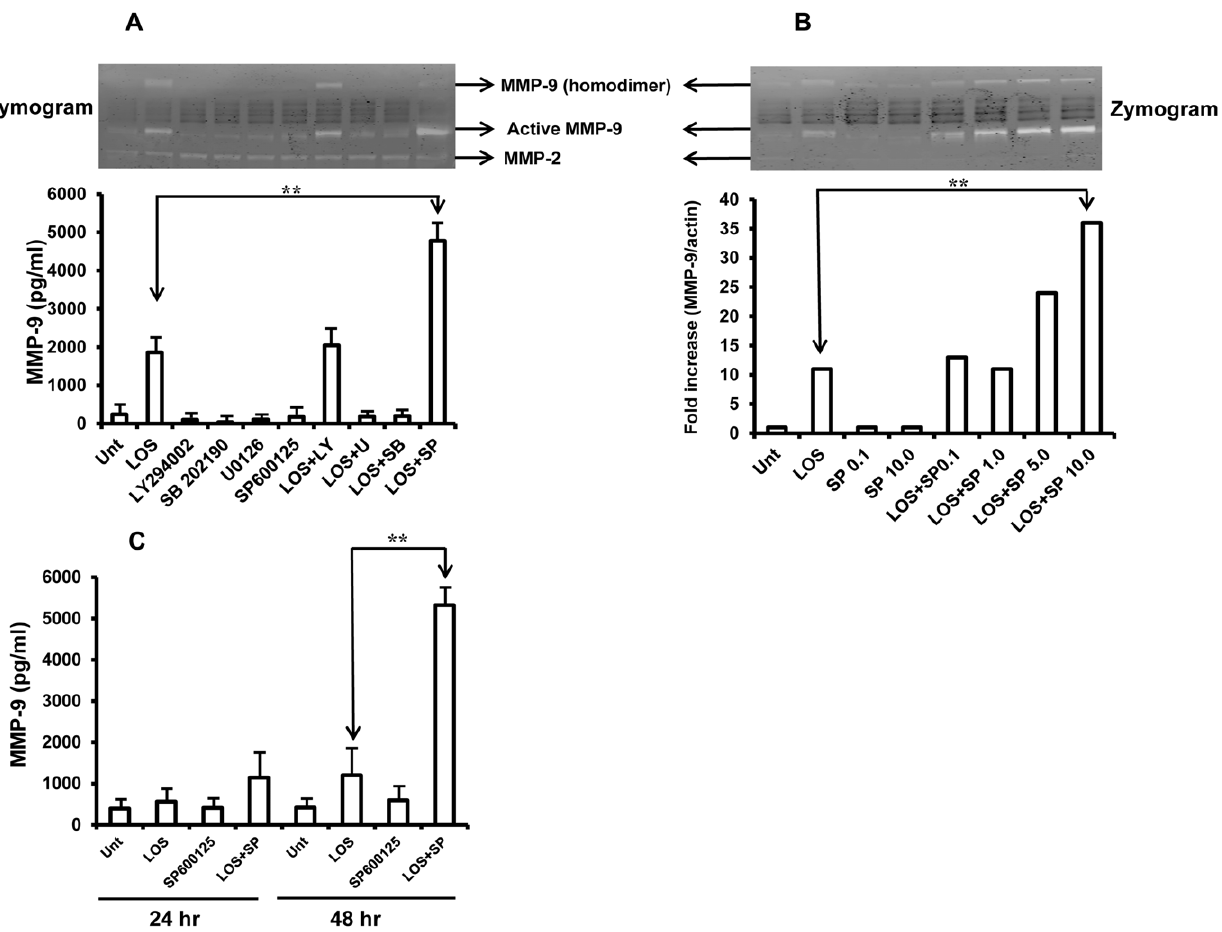
Figure 2. Inhibition of JNK1/2 by SP600125 increases LOS induced MMP-9 production in murine macrophages. A, RAW 264.7 cells were seeded in 96 well plate at 1 6 10 5 /100 m l/well. Cells were pretreated with AKT inhibitor LY 294002 (10 m M) and various MAPK inhibitors (ERK1/2 inhibitor U0126 (10 m M), p38 inhibitor SB202190 (10 m M) and JNK1/2 inhibitor SP600125 (10 m M) for 60 min and followed by LOS (100 ng/ml) treatment for 18 hrs. Supernatants were collected and activity of MMP-9 and MMP-2 were detected by zymogram (upper panel) and levels of MMP-9 were determined by ELISA (lower panel). B, RAW 264.7 cells were pretreated with different concentration of JNK1/2 inhibitor (0.1 m M, 1.0 m M, 5.0 m M and 10.0 m M) as indicated in figure followed by LOS treatment as described above. MMP-9 enzymatic activity and MMP-9 gene expression were determined by zymogram (upper panel) and real time-PCR, respectively (lower panel). C, Bone marrow derived macrophages were again pretreated with SP600125 (10 m M) for 1 hour followed by LOS treatment (100 ng/ml) for 48 hours. Cell culture supernatants were obtained and levels of MMP-9 were measured using ELISA kit. Typical results of three independent experiments are shown. ** ( p , 0.05, considered significant).